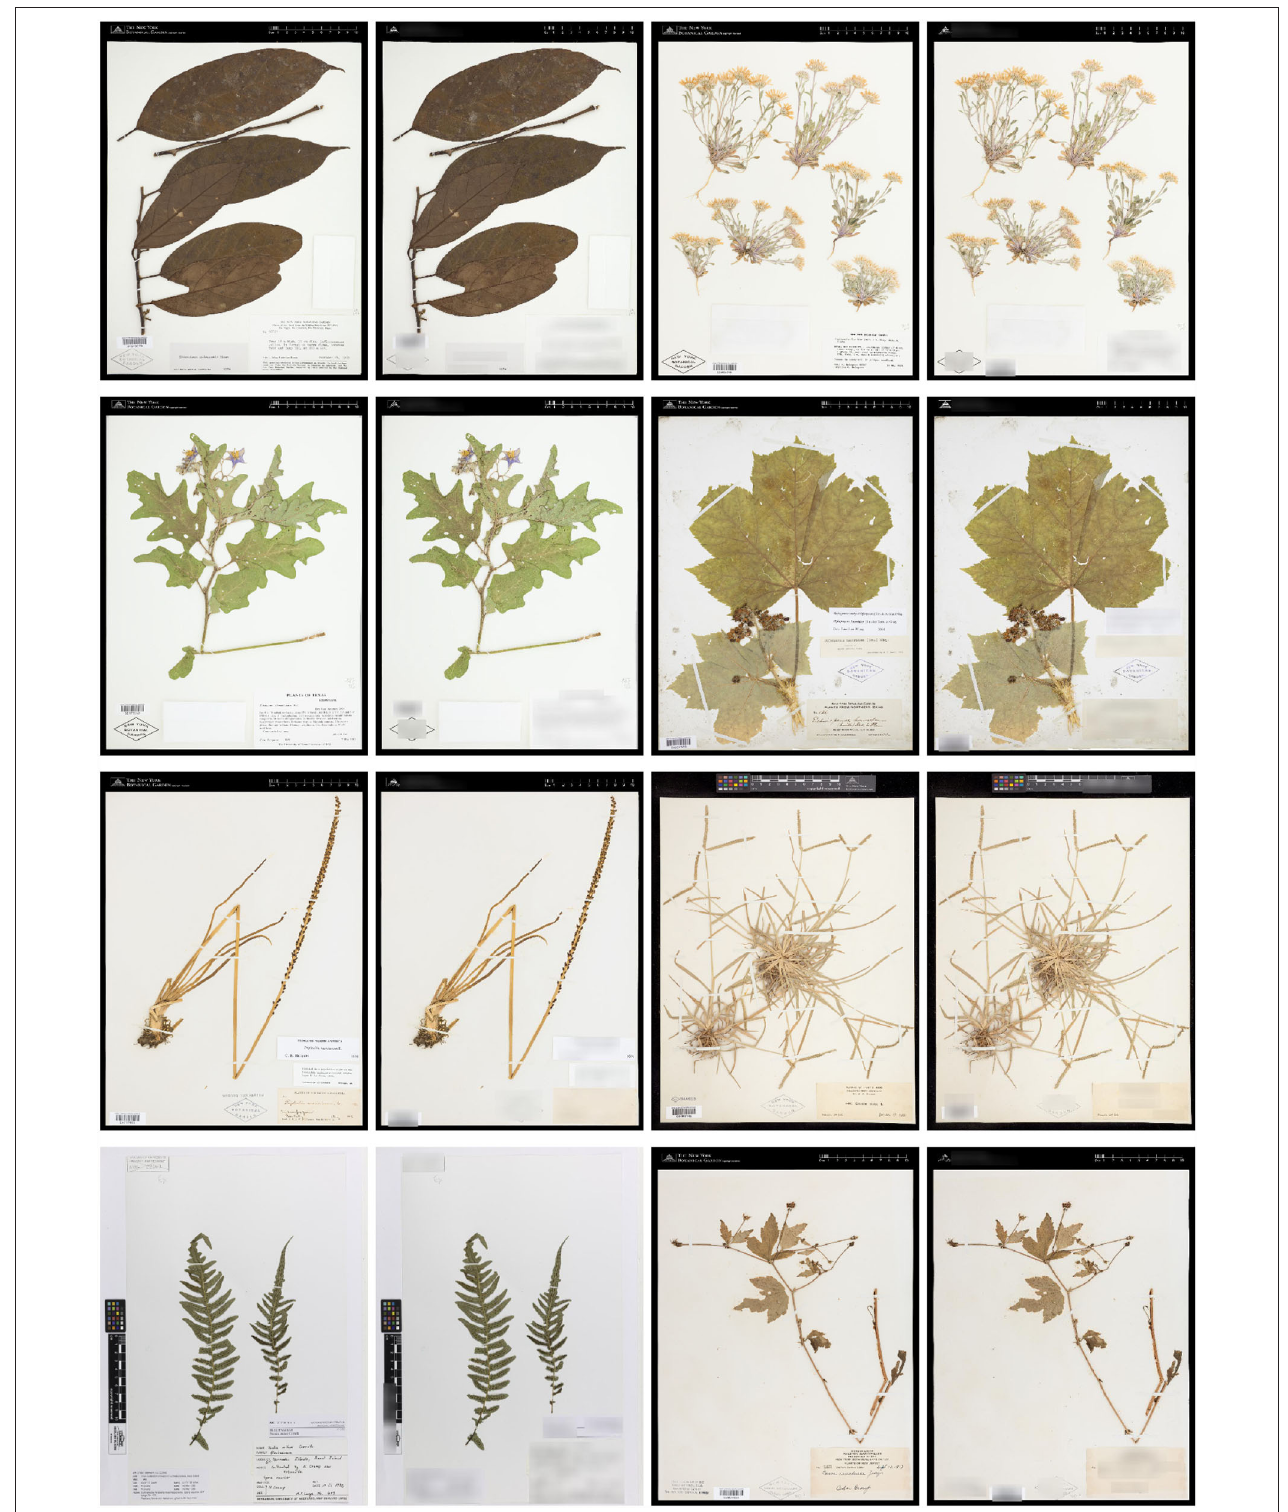
FIGURE 6 | Example of images before (left) and after (right) preprocessing.